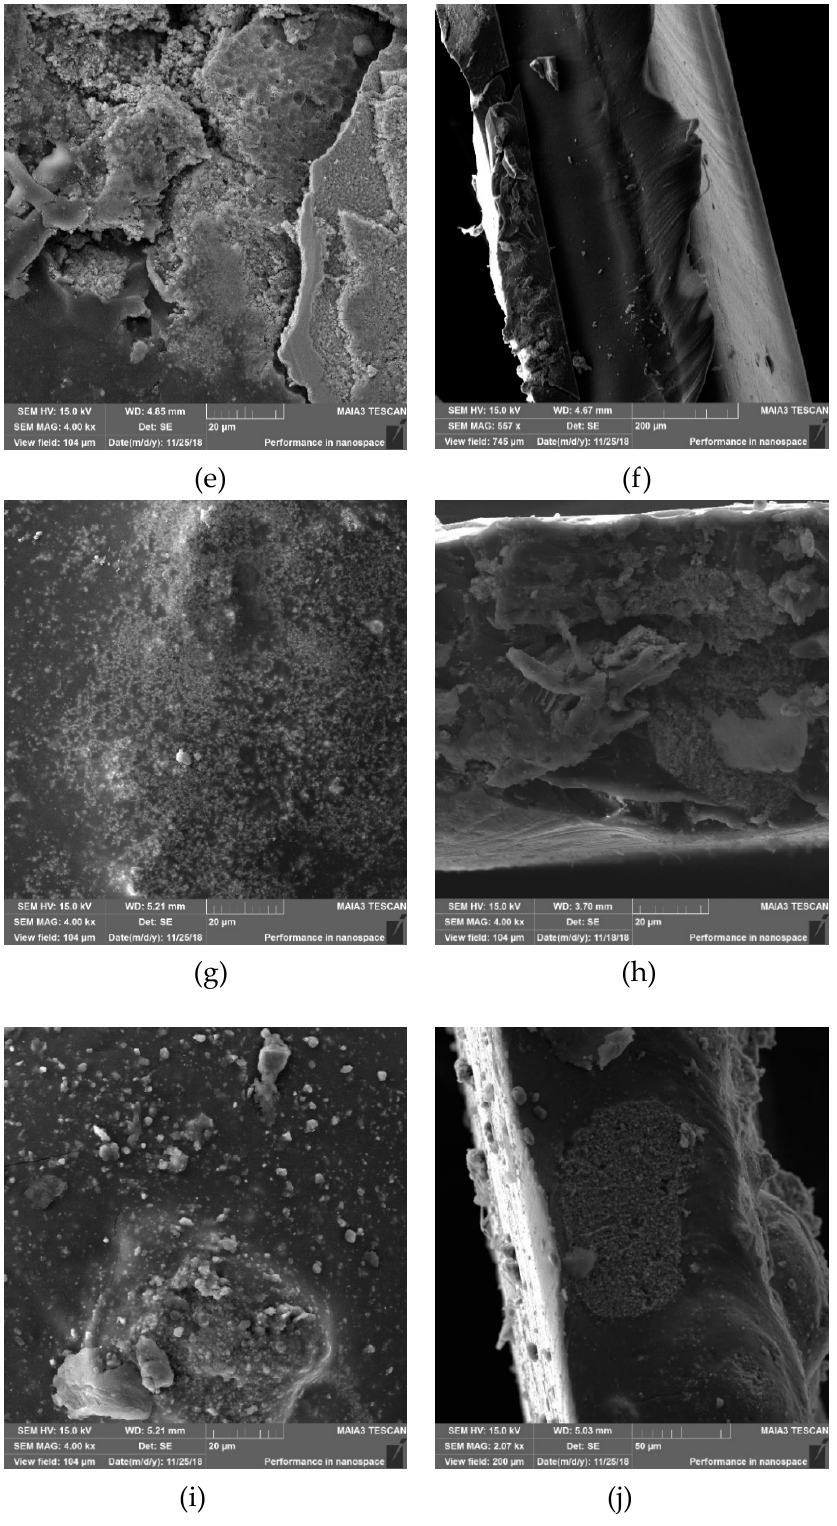
Figure 1. Scanning electron microscope (SEM) micrographs of Cu 2 ONPs immobilized onto linear low-density polyethylene (LLDPE) by extrusion: ( a ) surface and ( b ) cross-section images; by thermal adhesion: ( c ) surface and ( d ) cross-section images; using ethyl cyanoacrylate: ( e ) surface and ( f ) cross-section images; using epoxy resin: ( g ) surface and ( h ) cross-section images; using trimethoxyvinylsilane: ( i ) surface and ( j ) cross-section images.